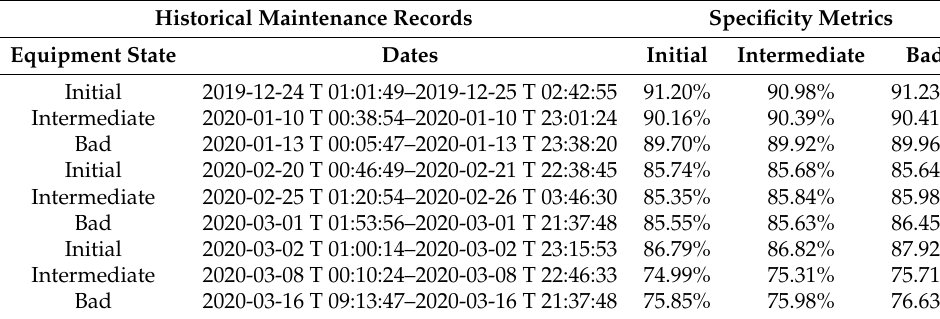
Table 5. LSTM-autoencoders specificity metrics.